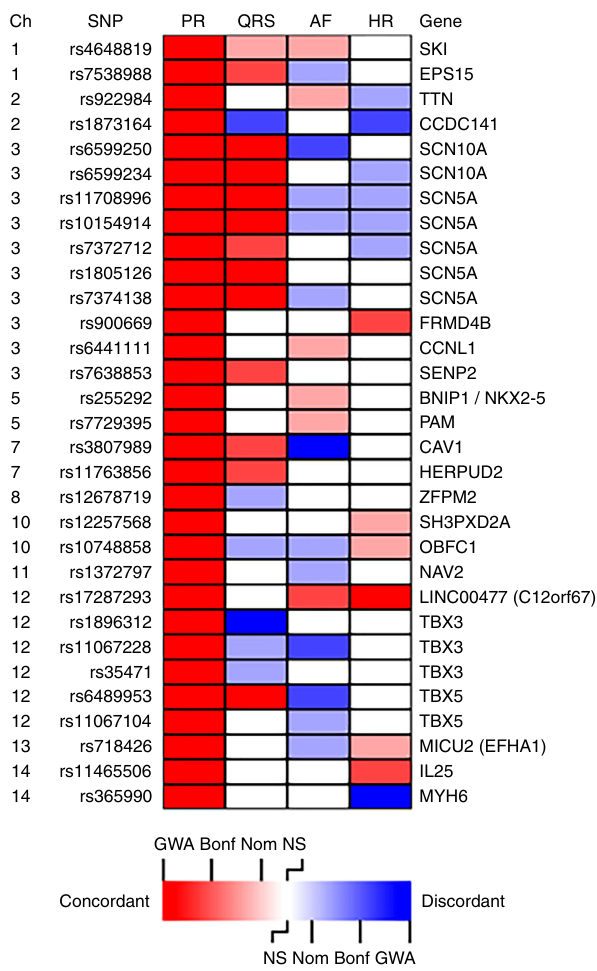
Fig. 3 Heatmap showing overlapping loci between four traits. For each locus associated with PR interval, we tested the strength of the association and direction of effect for three related traits: QRS duration, atrial fi brillation, and heart rate. While the genetic bases of these three traits show a distinct overlap with that of PR interval, we observe for each trait overlapping loci with both concordant and discordant associations, with some variants that prolong PR interval prolonging QRS duration or increasing heart rate (concordant associations), whereas others shorten QRS duration or decrease heart rate. Similarly, some variants that prolong PR interval increase AF risk (concordant association) while others decrease AF risk (discordant). Red color indicates concordant association with increasing PR associated with increasing QRS, or higher risk of AF, or higher HR. Blue color indicates discordant association of shortened QRS, or lower risk of AF, or lower HR. Intensity of color indicates signi fi cance of association: GWA (GWAS signi fi cant association), Bonf (Bonferroni corrected signi fi cance), Nom (nominal signi fi cance), NS (not signi fi